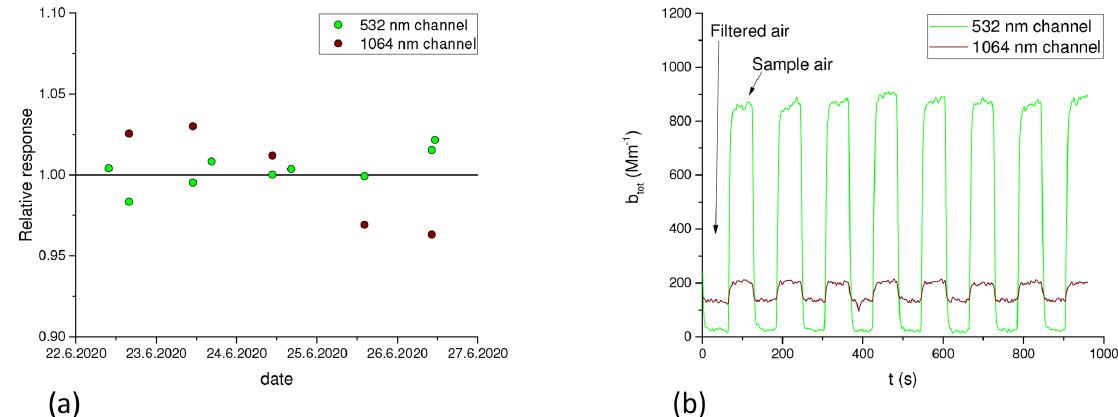
Figure 9. Validation of the PTAAM-2 λ sensitivity during the Ljubljana 2020 campaign (a) . Validation was performed by repeating the calibration experiments. Panel (b) shows the signal during nigrosin calibration. To obtain the absorption coefficient of nigrosin, the offset obtained for filtered air was subtracted from the sample air signal.